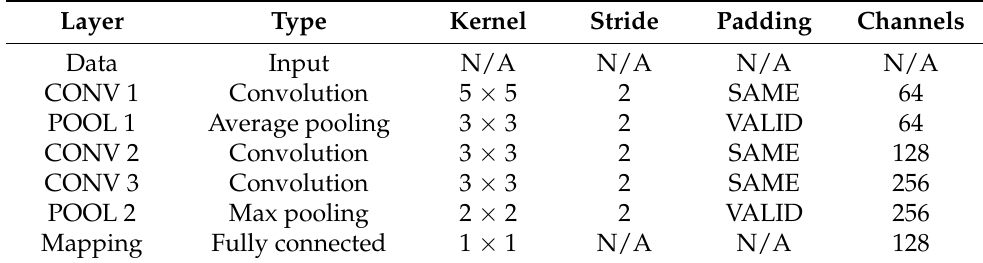
Table 1. Configuration of feature extractor